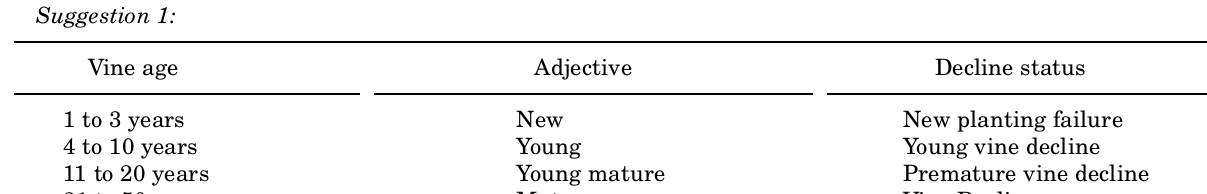
Table 3. Suggestions for vine age and decline definitions. Suggestion